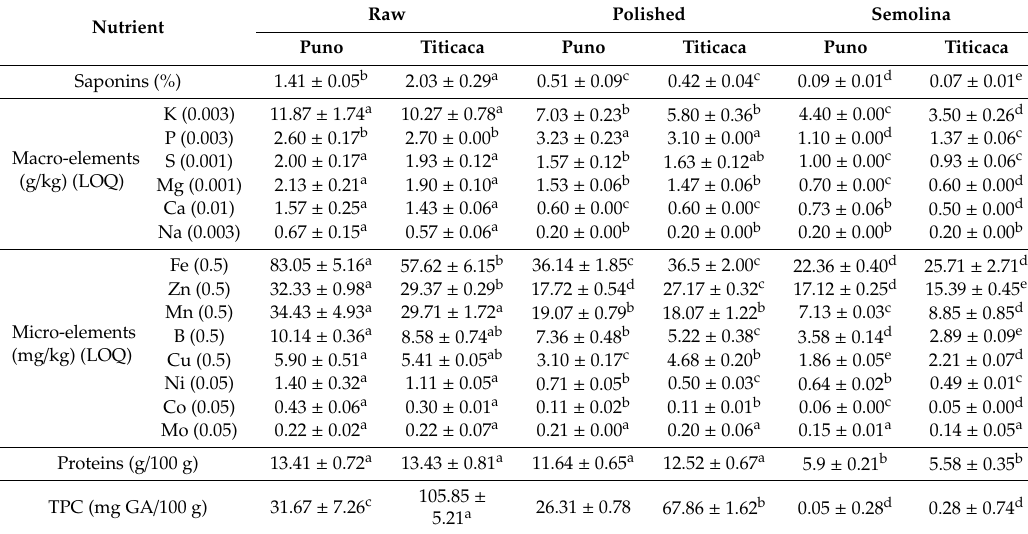
Table 1. Means and standard deviation of saponin content, mineral concentrations, protein content, and Total Phenolic Compounds in raw and processed quinoa seeds of cv. Puno and cv. Titicaca. Raw Polished Semolina Nutrient Puno Titicaca Puno